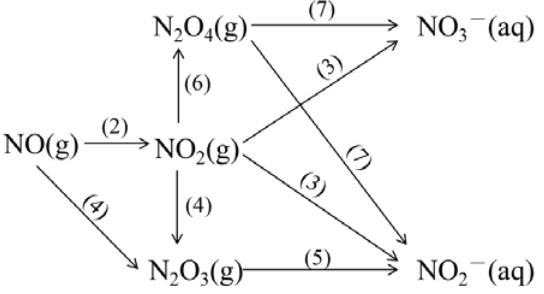
Figure 12. Reaction pathways of NO with the NaClO 2 mist.